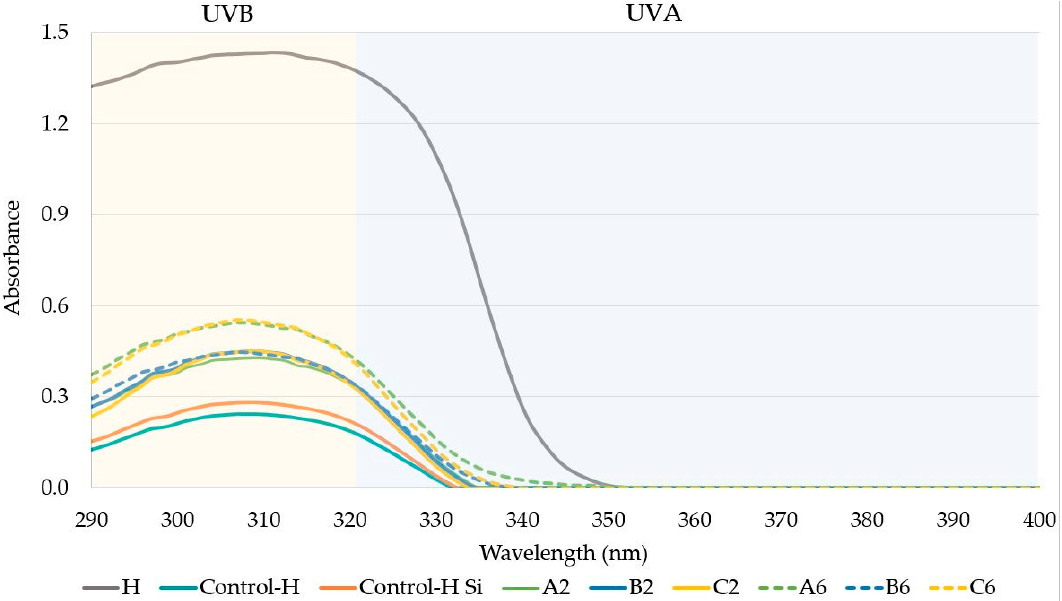
Figure 4. Ultraviolet (UV) absorption peak of sunscreen made with homosalate as the UV filter.